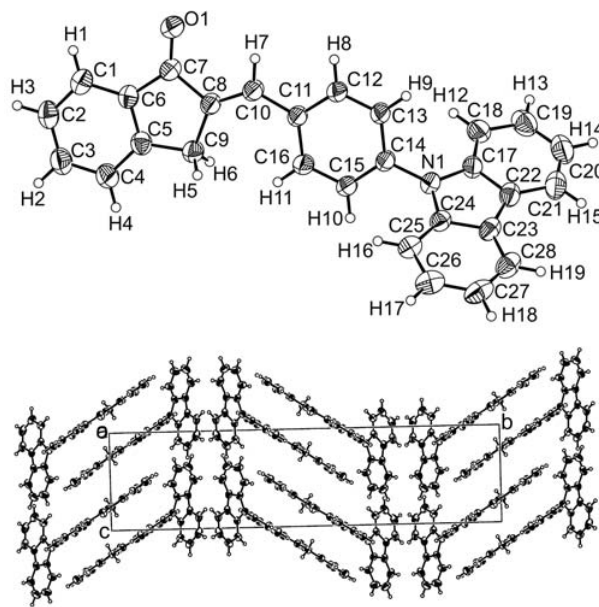
(figure, top). The electro-withdrawing moiety (C1, C2, C3, C4, C5, C6, C7, C8 and O1) and electro-donating moiety (C17, C18, C19, C20, C21, C22, C23, C24, C25, C26, C27, C28 and N1) of